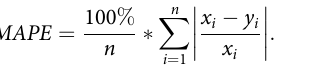
TABLE 2 Correlation coef fi cients in combination with concordance and variance analysis including MAE, MAPE and maximal percentage error. Figure Pearson Intraclass correlation coef fi cient (r) Figure 1